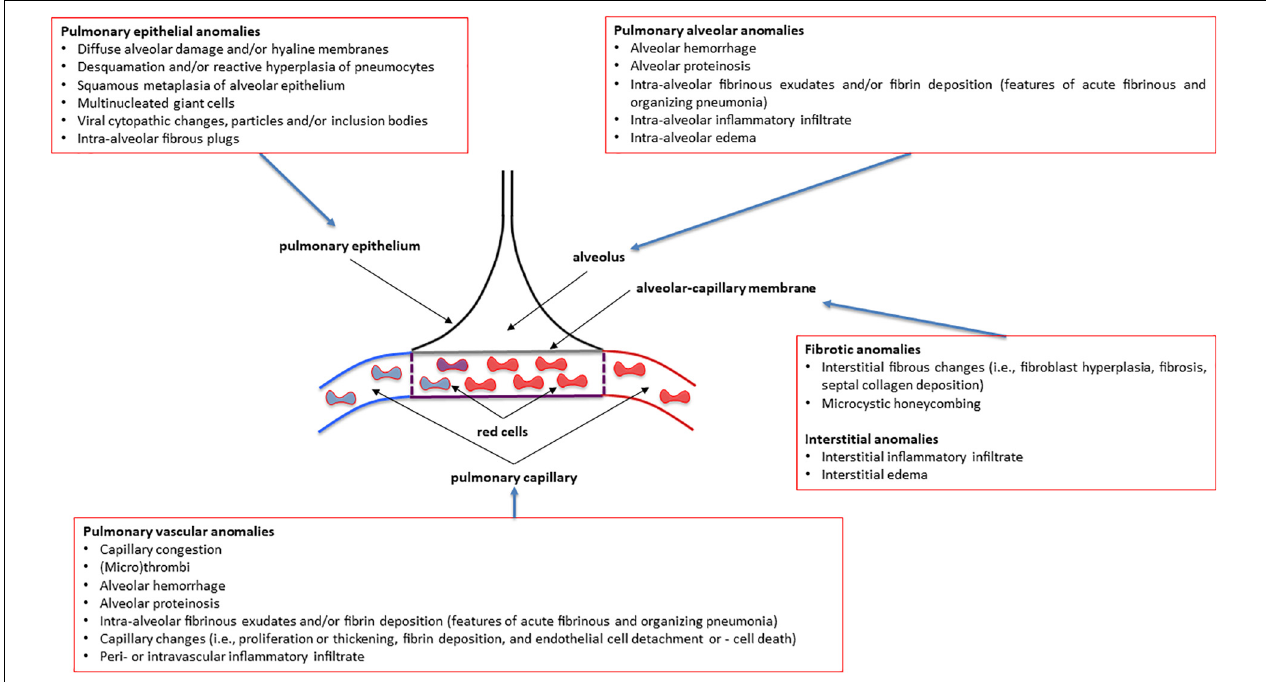
FIGURE 1 | Overview of the most common pulmonary pathology findings observed in post-mortem patients affected by various degrees of severity of COVID-19 (coronavirus disease 2019). See the text for more details and explanations. This is an original figure, no permission to reproduce is